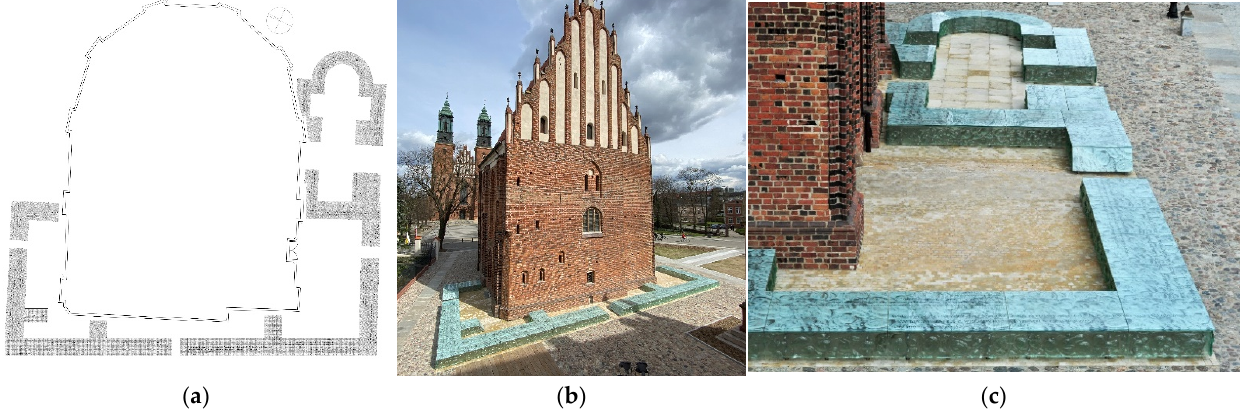
Figure 12. Glass art installation by Tomasz and Konrad Urbanowicz representing the outline of the first Piast Dynasty residence and chapel, Poznań, Wrocław, 2021: ( a ) a plan of the wall’s outline with a large-scale graphic design of approx. 25 × 30 m; ( b ) aerial view from the northwest corner towards the cathedral; ( c ) aerial view from the southwest corner towards the cathedral (Konrad